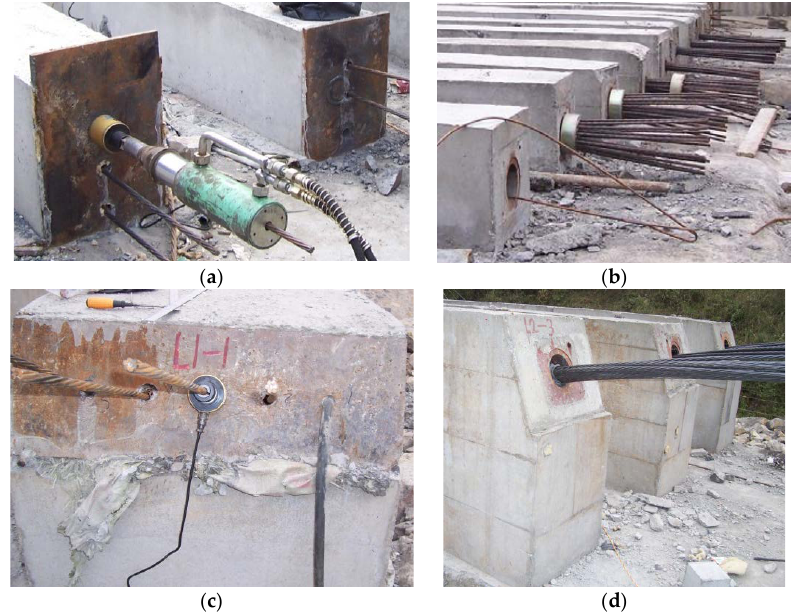
Figure 6. General view of the specimens: ( a ) straight tendons with 1 wire; ( b ) curve tendons with 19 wires; ( c ) curve tendons with 1 wire; and ( d ) curve tendons with 19 wires.